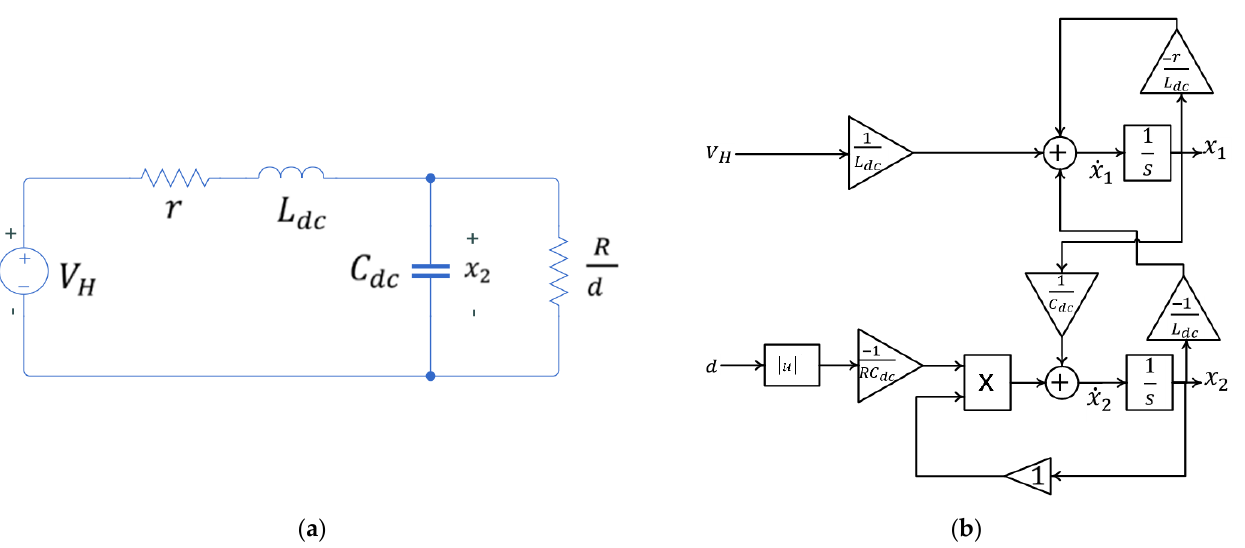
Figure 2. Averaged equivalent circuit ( a ) and dynamic model ( b ) of the EMA converter. Considering (𝑥 1 , 𝑥 2 ) 𝑇 = (𝑖 𝐿𝑑𝑐 , 𝑉 𝑖 ) 𝑇 as a state vector of the system in Figure 2a, the av- eraged state-space model of the EMA emulator can be written as follows. It should be noted that in this equation, the parameter 𝑅 refers to the load resistance.